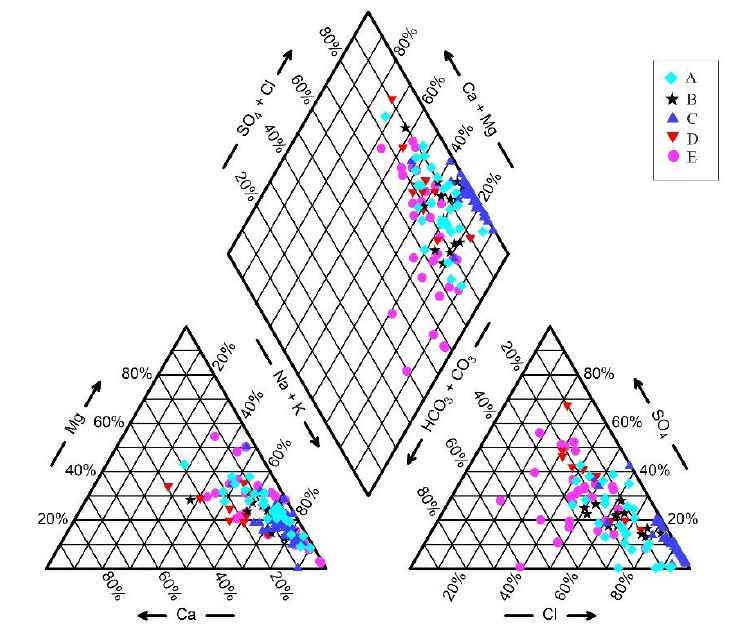
Figure 5. Three-line diagram of highly mineralized water distribution zone in Hetao.